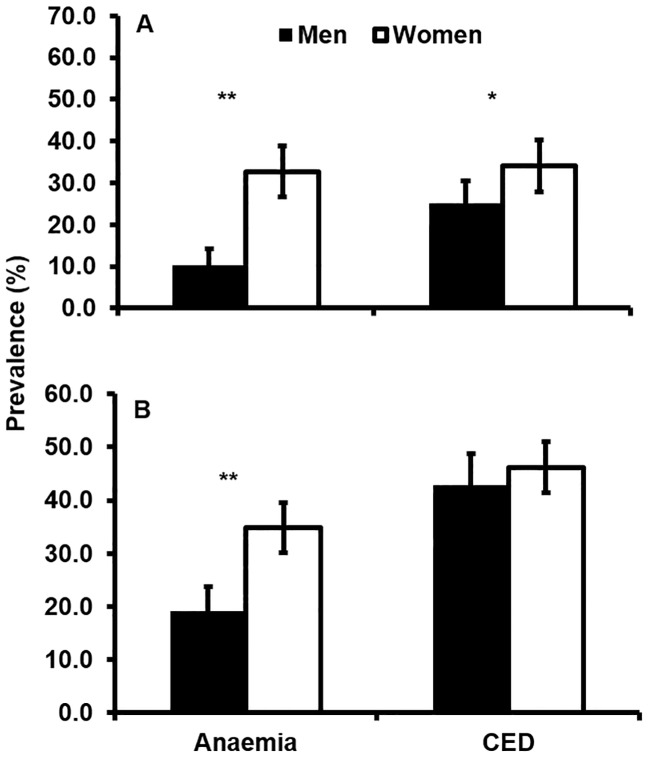
Prevalence of Anaemia and CED in men and women aged 18 years and over.Panel 1A shows data for ‘not low’ income families (>1,000 rupees per month) while panel 1B shows data for low income families (≤1,000 rupees per month). Anaemia was defined according to WHO individual haemoglobin (Hb) levels: Hb <12 g/dL for non-pregnant women, Hb <11 g/dL for pregnant women, and Hb <13 g/dL for men. CED was defined in both genders as a BMI <18 kg/m2. (n = 524 men and 635 women). Error bars show 95% Confidence Intervals. Black bars show data for men and white bars show data for women. ** denotes significance at p<0.001;* denotes significance at p<0.05.